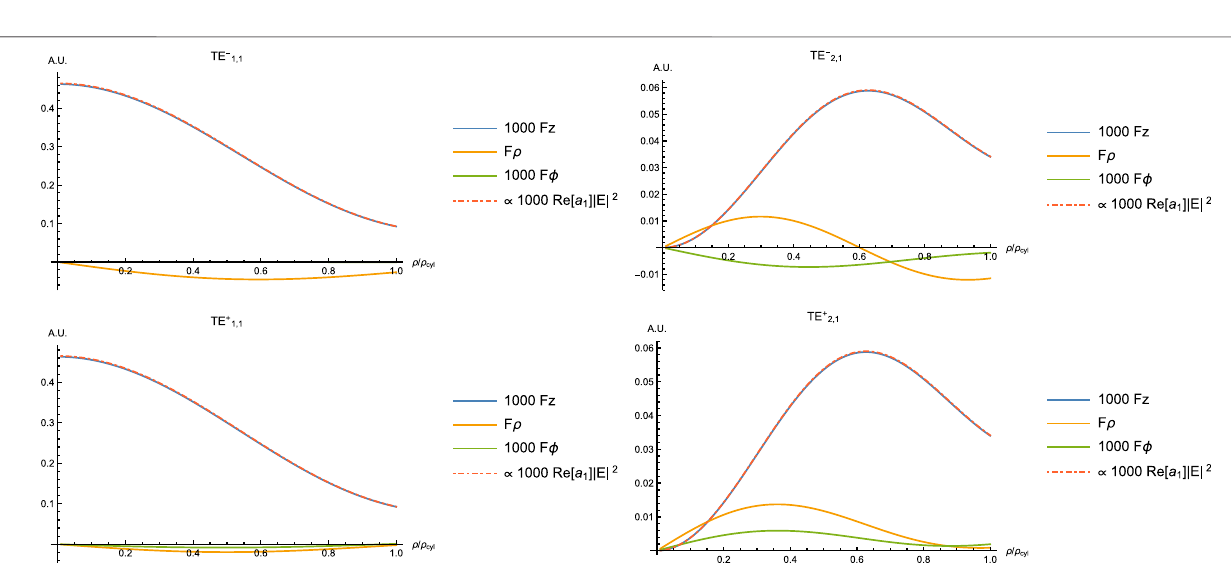
FIGURE 4| First TE modes: optical forcesseen as pro fi le from the center tothe walls ofthe waveguide. Depending on the mode F ρ can be always positive, always negative,orchangethesignacrossthe waveguide pro fi le.Calculationswere performed usingthefullexpressions on Eq5 ,assuming awaveguideradiusof5 µm, anda size parameter x (cid:1) 0.1. Note that F z ∝ | E | 2